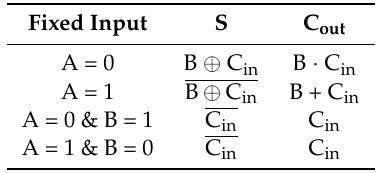
Table 1. Logic operations that can be performed with a Full Adder by fixing one or more of the inputs. In this case A, B and C in are the three inputs while S and C out are the output (sum and output carry,